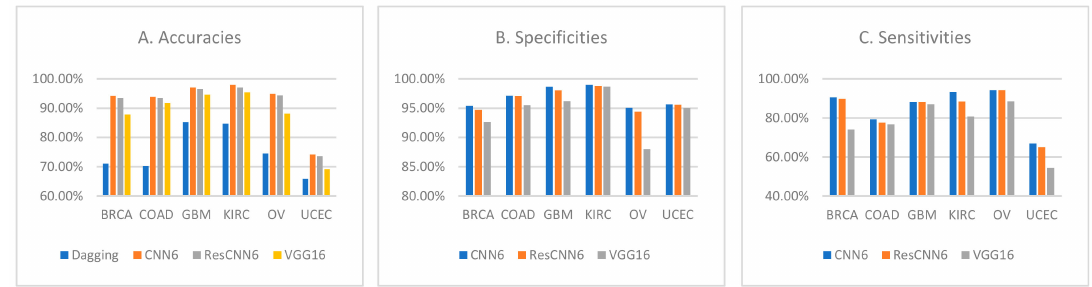
Figure 6. Comparison of the classifiers’ per-class ( A ) accuracies, ( B ) specificities, and ( C )